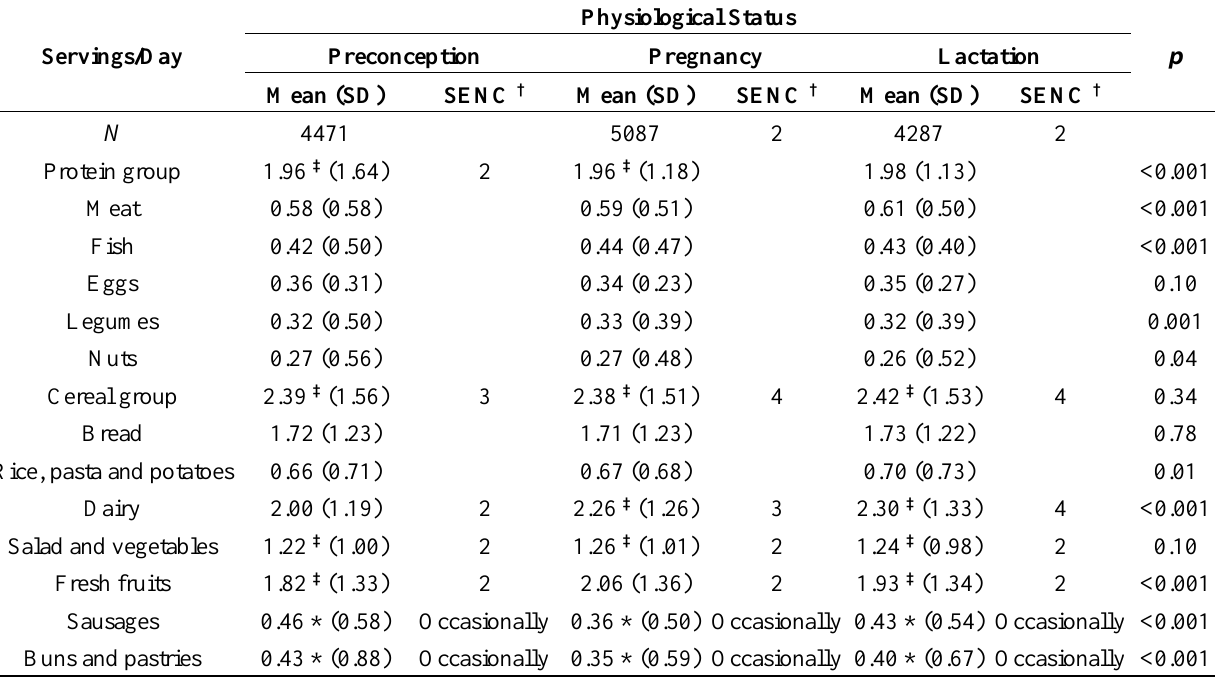
Table 2. Mean (SD) of daily serving consumption in women according to physiological status.